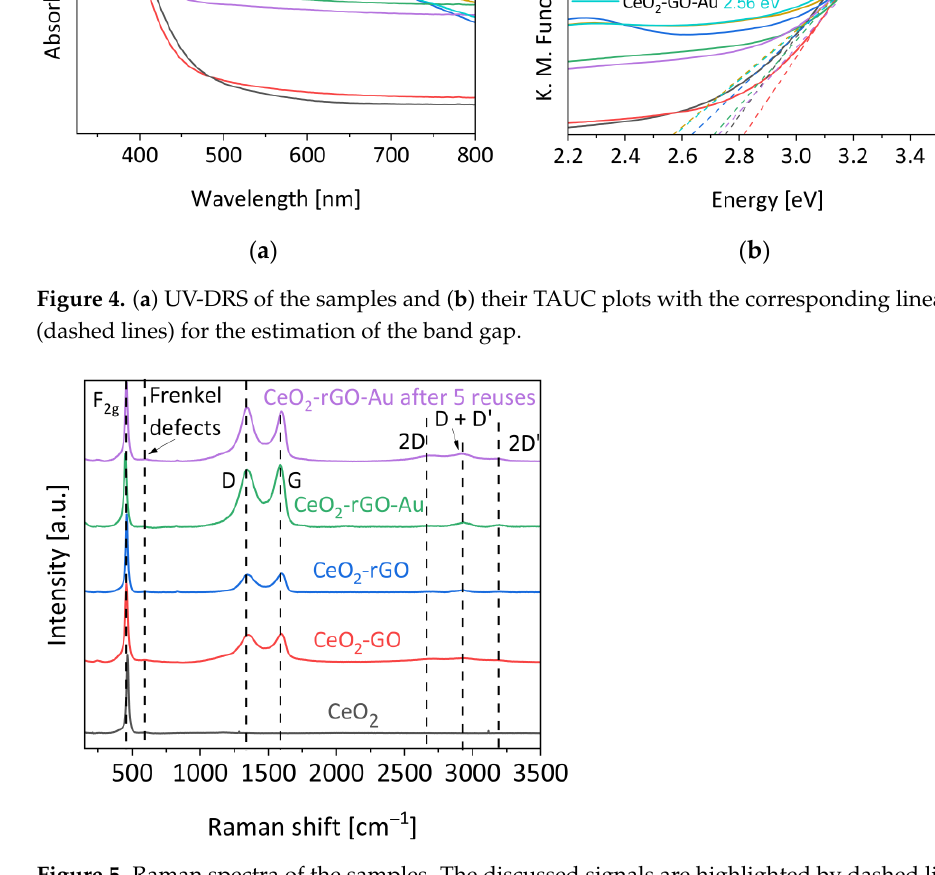
Figure 5. Raman spectra of the samples. The discussed signals are highlighted by dashed lines.